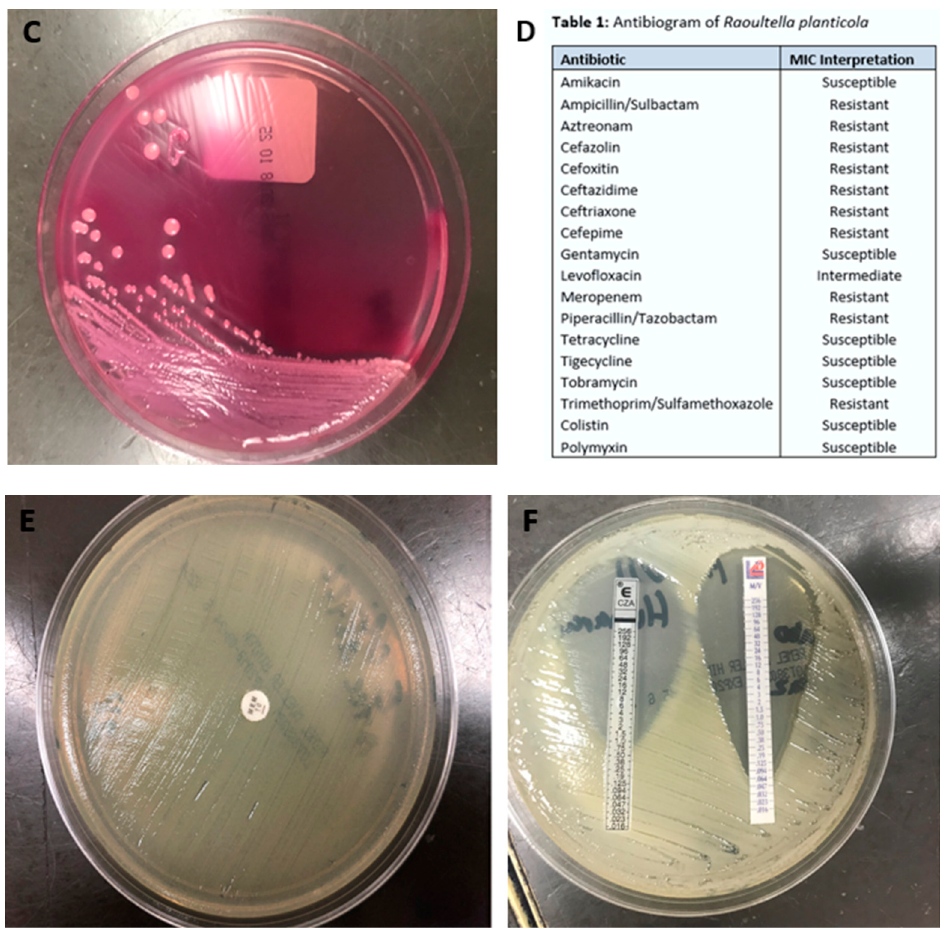
Figure 1. An 85 ‐ year ‐ old woman presented to the hospital after sustaining burn injuries and smoke exposure from a house fire. On admission, she was tachypneic, with a respiratory rate of 20 breaths per minute. Her physical exam was significant for 2nd degree burns along the dorsal and palmar aspects of her first three fingers on the right hand and partially on the index finger and thumb of her left hand. She had 1st degree burns on the rest of her hands and both forearms, as well as on the entire face and neck. Her wounds were debrided and silvedene was applied on her hands and forearms, while bacitracin was used for her face. Shortly after admission, the patient experienced difficulty breathing, trouble swallowing, voice changes and swelling around her mouth and tongue. She was intubated for airway protection and was transferred to the intensive care unit (ICU). She was extubated 2 days later, but re ‐ intubated after an episode of projectile vomiting and aspiration. Due to the development of fevers, blood and urine cultures were taken. She was started on cefepime 2 g every 12 h and vancomycin 15 mg/kg every 12 h for aspiration pneumonia. Blood culture grew methicillin ‐ sensitive Staphylococcus aureus and urine culture was positive for Morganella morganii. Four days later, she developed spontaneous pneumothorax that required chest tube placement. Persistence of fever and worsening leukocytosis prompted antibiotic escalation to meropenem with continuation